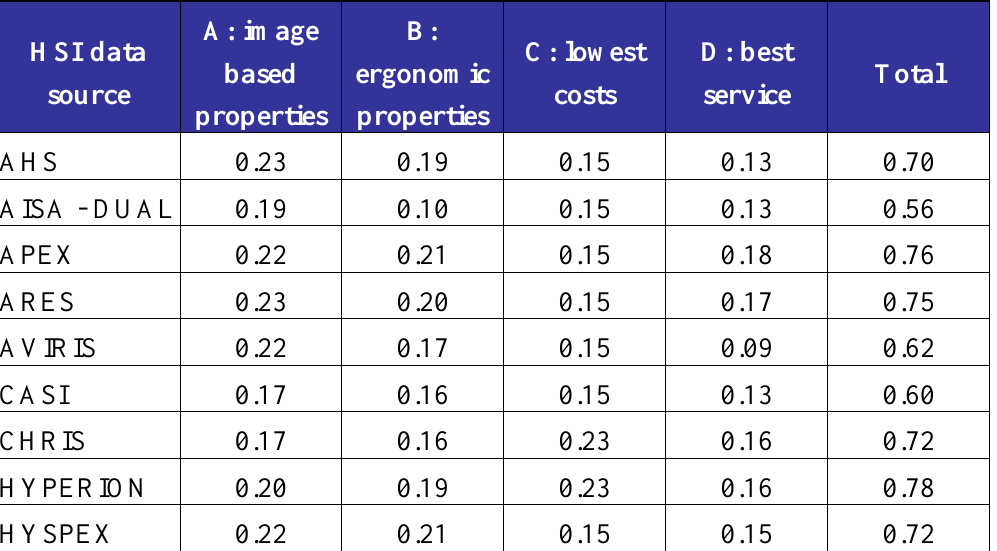
Table 3. Relative values of the 2 nd objective level for various HSI data and the application vegetation (A: image based properties, B: ergonomic properties, C: lowest costs, D: best